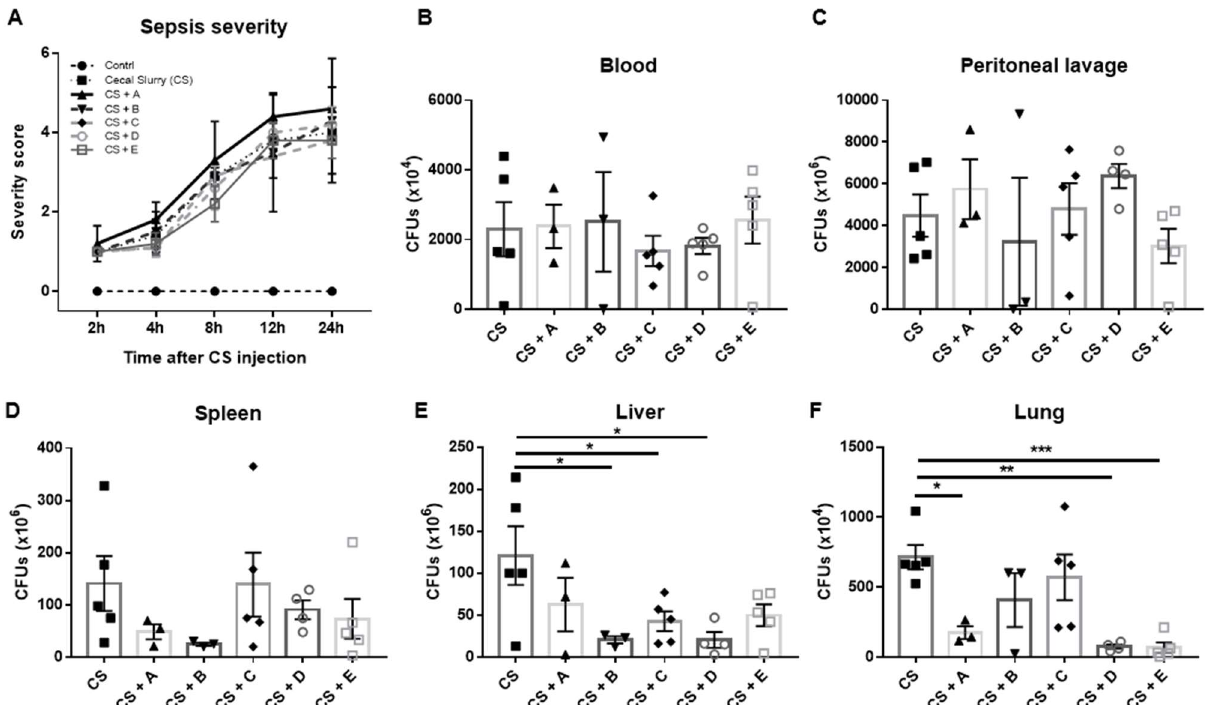
Figure 3. Effect of the Greek honey types’ administration on CS-induced sepsis: ( A ) severity score of sepsis and the bacterial load in the ( B ) blood, ( C ) peritoneal lavage, ( D ) spleen, ( E ) liver, and ( F ) lungs of CS-injected mice. All graphs represent measurements from 5 mice per group and show the mean ± SEM. In the post-hoc test, the CS-injected group was selected as the control group for multiple comparisons with the honey-treated groups: * p < 0.05, ** p < 0.01, and *** p < 0.001. The absence of an asterisk indicates no statistical significance. A: Epirus arbutus; B: Evros chestnut; C: Epirus fir; D: Crete fir; E: Manuka honey. Clinical scoring system: 0 = no abnormal clinical signs; 1 = ruffled fur but lively; 2 = ruffled fur, moving slowly, hunched, and sick; 3 = ruffled fur, squeezed eyes, hardly moving, down, and very sick; 4 = same as 3 but with incontinence; 5 = moribund. The bacterial burden was evaluated in the blood, peritoneal lavage, and tissues of the CS-treated mice. The bacterial counts in the blood and peritoneal lavage were not different